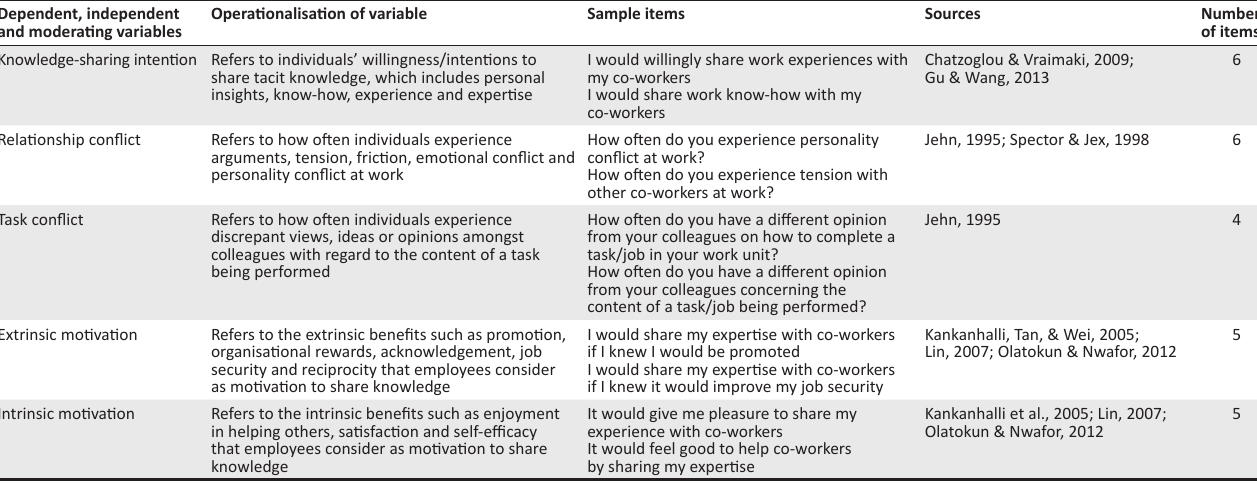
TABLE 1: Operationalisation of the dependent, independent and moderating variables. Dependent, independent Operationalisation of and moderating variables